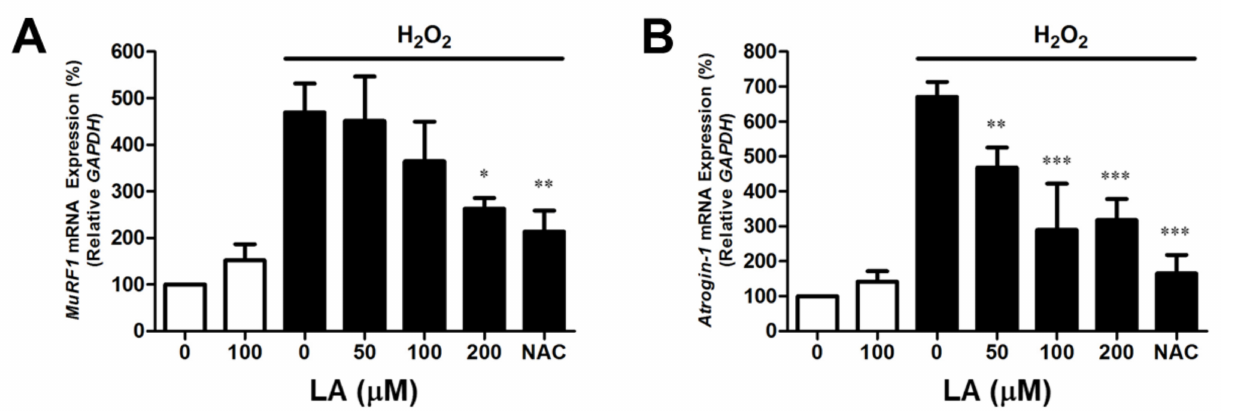
Figure 2. Linoleic acid decreases MuRF1 and Atrogin-1/MAFbx mRNA expression in oxidative stress- induced C2C12 myoblasts. C2C12 myoblasts were cultured with serum-free DMEM containing LA (0–200 µ M). Cell lysis and mRNA extraction were performed using Tri-reagent. cDNA was synthesized according to the manufacturer’s instructions. mRNA expression was analyzed by using SYBR Green 1 and a LightCycler ®96 instrument. ( A ) MuRF1 mRNA expression. Each value indicates the mean ± SD ( n = 6). ( B ) Atrogin-1/MAFbx mRNA expression. Each value indicates the mean ± SD ( n = 6). * p < 0.05, ** p < 0.01, *** p < 0.001 vs. H 2 O 2 alone. The effect of LA was compared with that